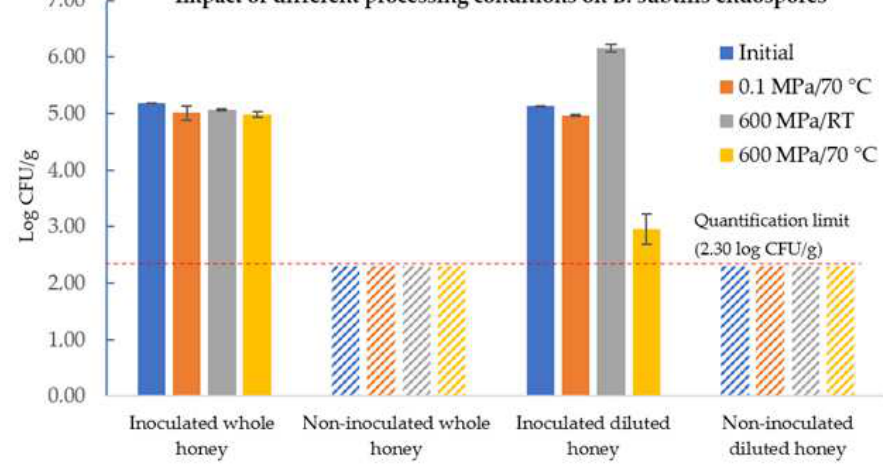
Figure 6. Effect of different processing conditions (thermal pasteurization, 70 ◦ C/15 min), nonthermal HPP (600 MPa/15 min, RT), and PATP (600 MPa/15 min/70 ◦ C) on B. subtilis endospores inoculated in HWP with an a W of 0.96. Dashed bars mean that the loads were below the quantification limit of 2.30 log CFU/g.